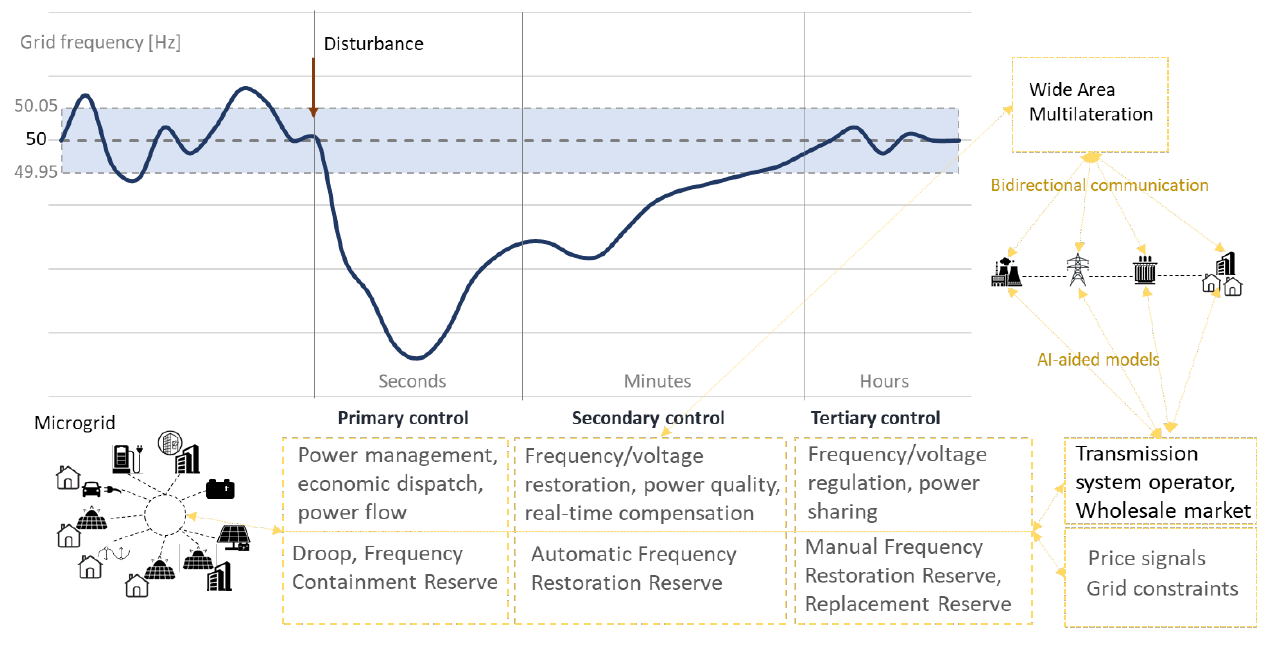
Figure 5. AI-aided fault